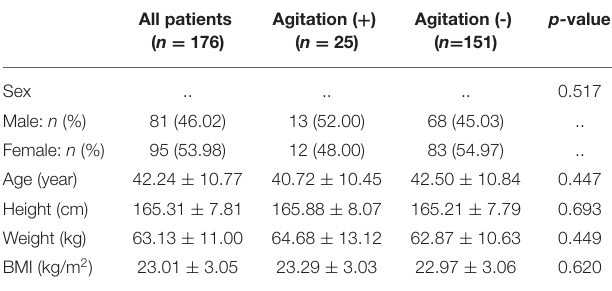
TABLE 1 | Characteristics of included patients ( n = 176). All patients ( n =